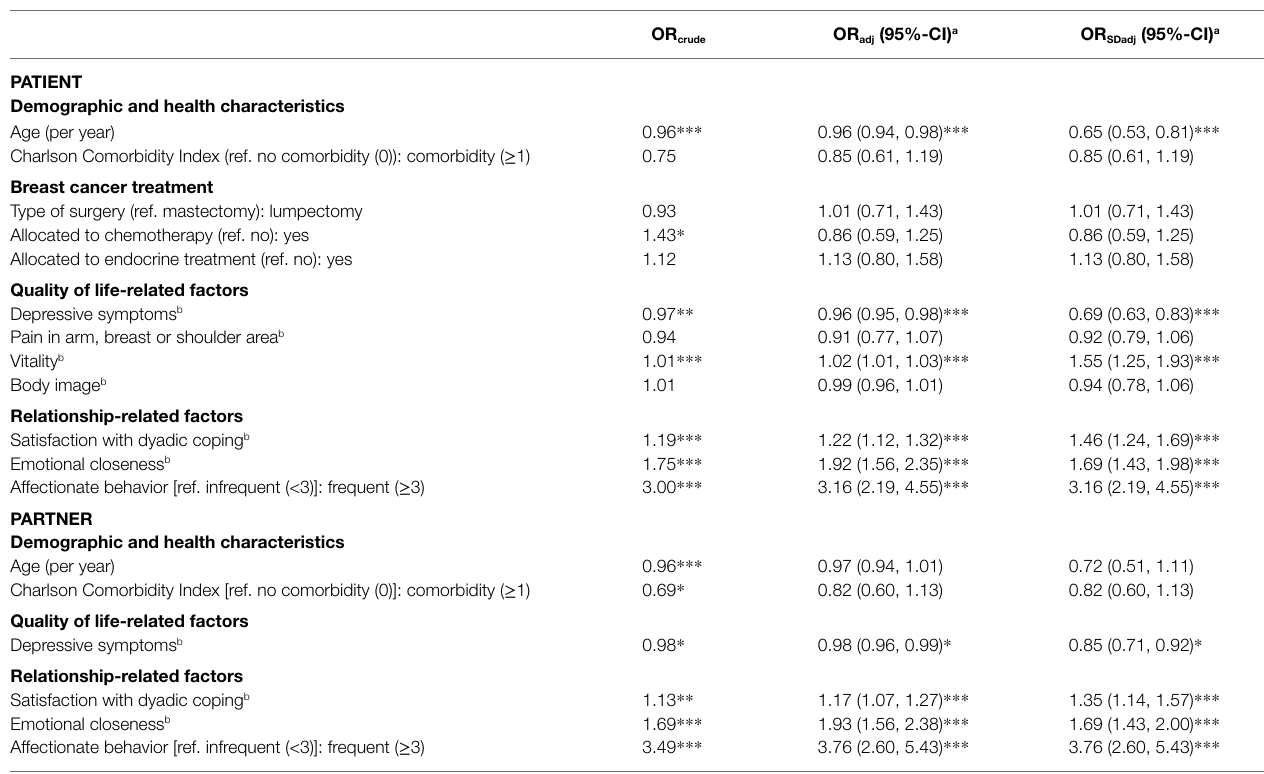
TABLE 3 | Associations between patient and partner characteristics and sexual activity at